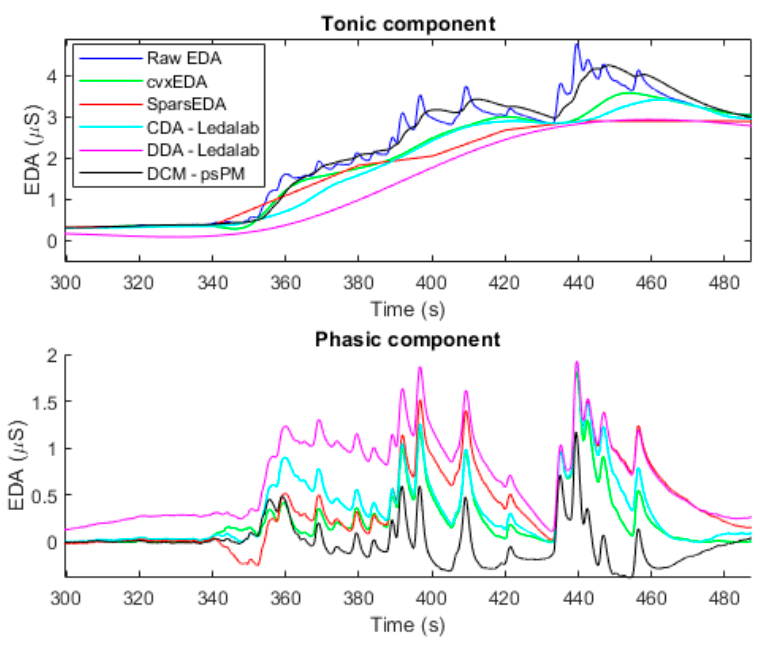
Figure 4. Tonic/phasic decomposition of a sample EDA signal using some available tools. Figure 4. Tonic / phasic decomposition of a sample EDA signal using some available